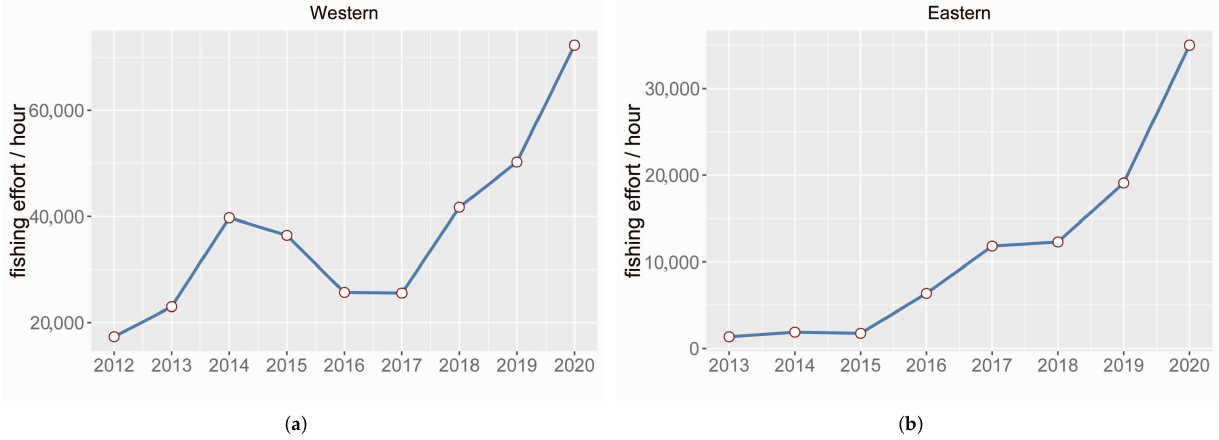
Figure 2. ( a ) Annual fishing effort to the west of 170 ◦ E. ( b ) Annual fishing effort to the east of 170 ◦